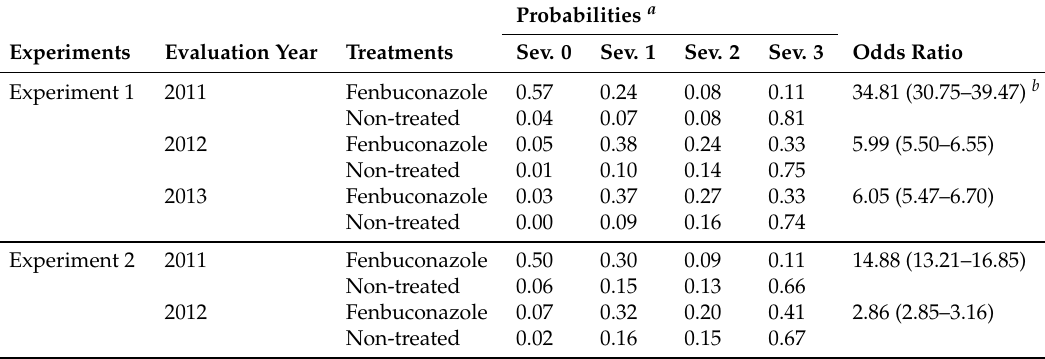
Table 4. Probabilities and odds ratios obtained with the proportional odds logistic regression of greasy spot severity categories in experiment 1 on ‘Start Ruby’ grapefruit at Tambo and experiment 2 on ‘Valencia’ sweet orange at Miraflores, Panama from 2011 to 2013.